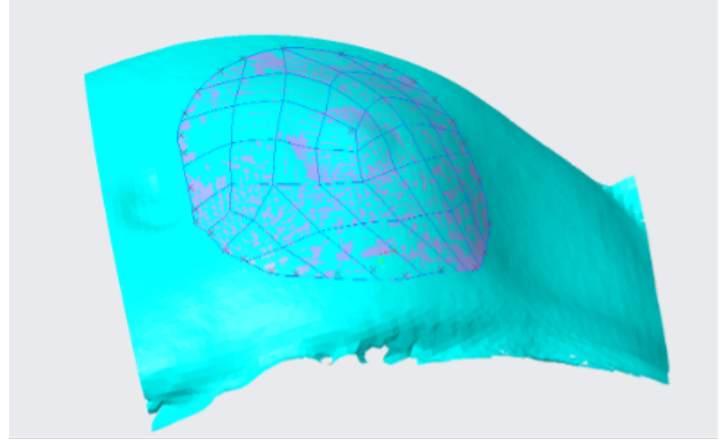
Figure 13. Quilt generated after the reconstruction process.